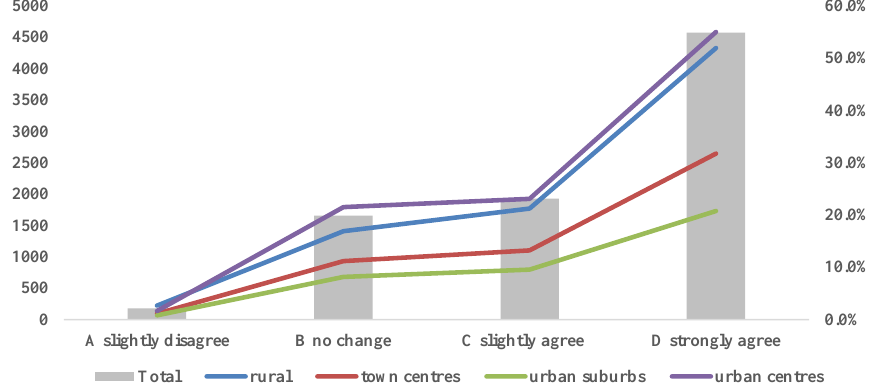
Figure 2. Interviewees’ views on “human and nature should live in harmony and fear nature”.